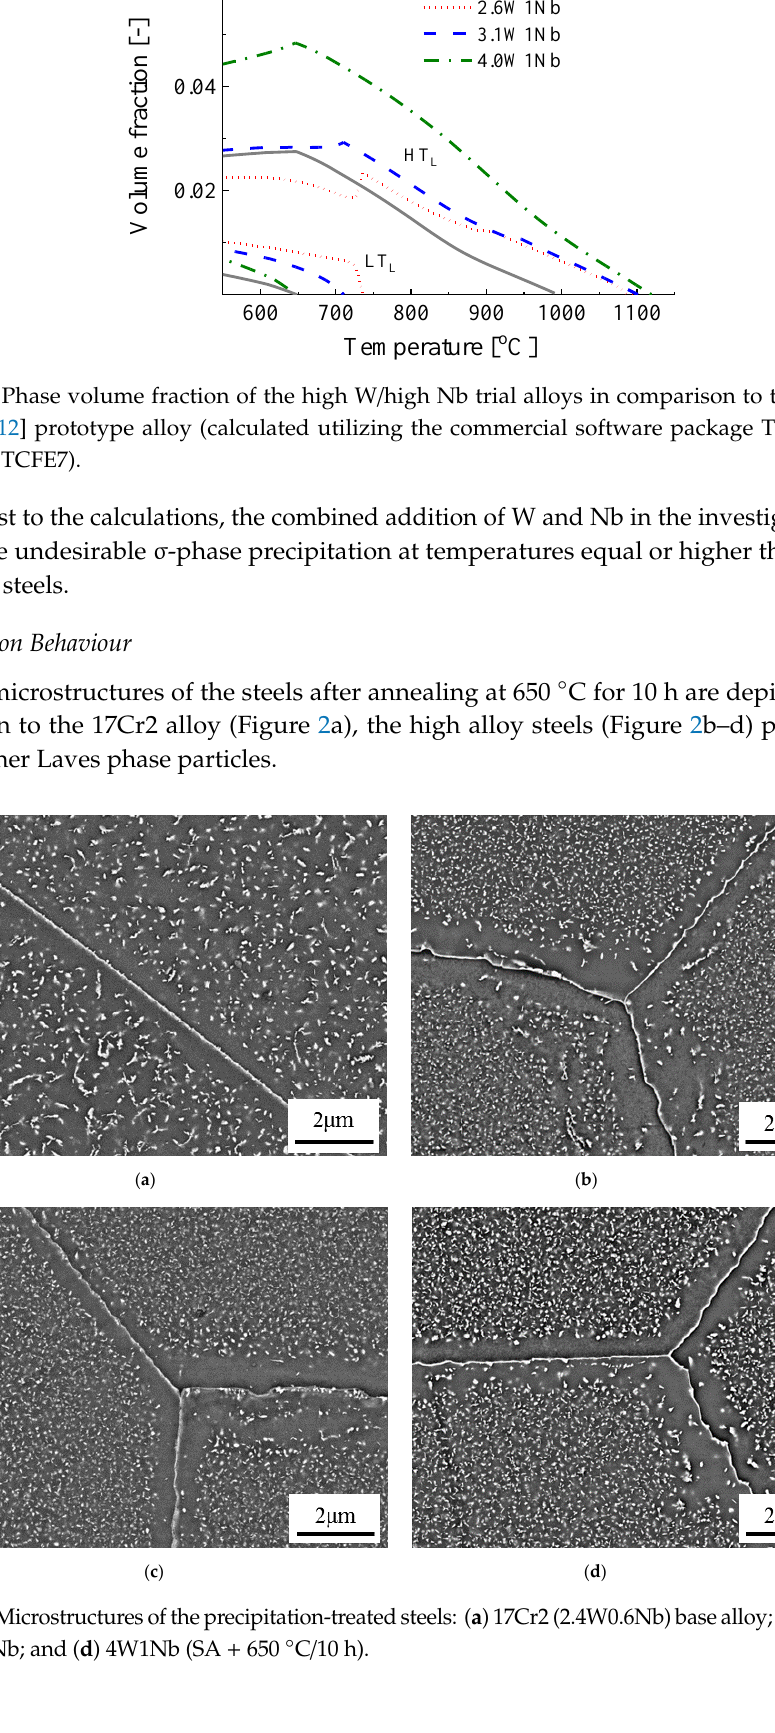
( b ) Figure 3. Evolution analysis during annealing at 650 °C: ( a ) volume fraction evolution; ( b ) average equivalent circle diameter (ECD) evolution. Within the range of scatter, but still significant, all the alloys presented complex, “wavy” area fractions and ECD evolution. Precipitation of the LT L and HT L phases took place at differing kinetics [15–18], which directly influenced the results of quantitative image analysis. Undoubtedly, all the trial alloys provided higher precipitate fractions after 1000 h of aging (Figure 3a). The measured fractions were almost a factor of two higher than predicted by thermodynamic calculation (Figure 1), which is most probably caused by the fact that, after just 1000 h at the annealing temperature of 650 °C, equilibrium conditions were not yet reached. With increasing W-content, the mean particle diameter decreases by about 20% (Figure 3b). The impact of Nb-addition can be directly observed from comparison of the 17Cr2 base (2.4W0.6Nb) to the 2.6W1Nb trial alloy. Nb obviously increased the volume fraction of precipitates mainly during a short time of annealing (Figure 3a) and additionally refined the particles (Figure 3b). Because Nb is the main element in LT L phase core nucleation [15–18], the concentration of Nb directly influenced nucleation kinetics and amount of the initially formed Laves LT L phase precipitates. At 1 wt.% of Nb concentration, the extra addition of W further increased particle volume fraction. The